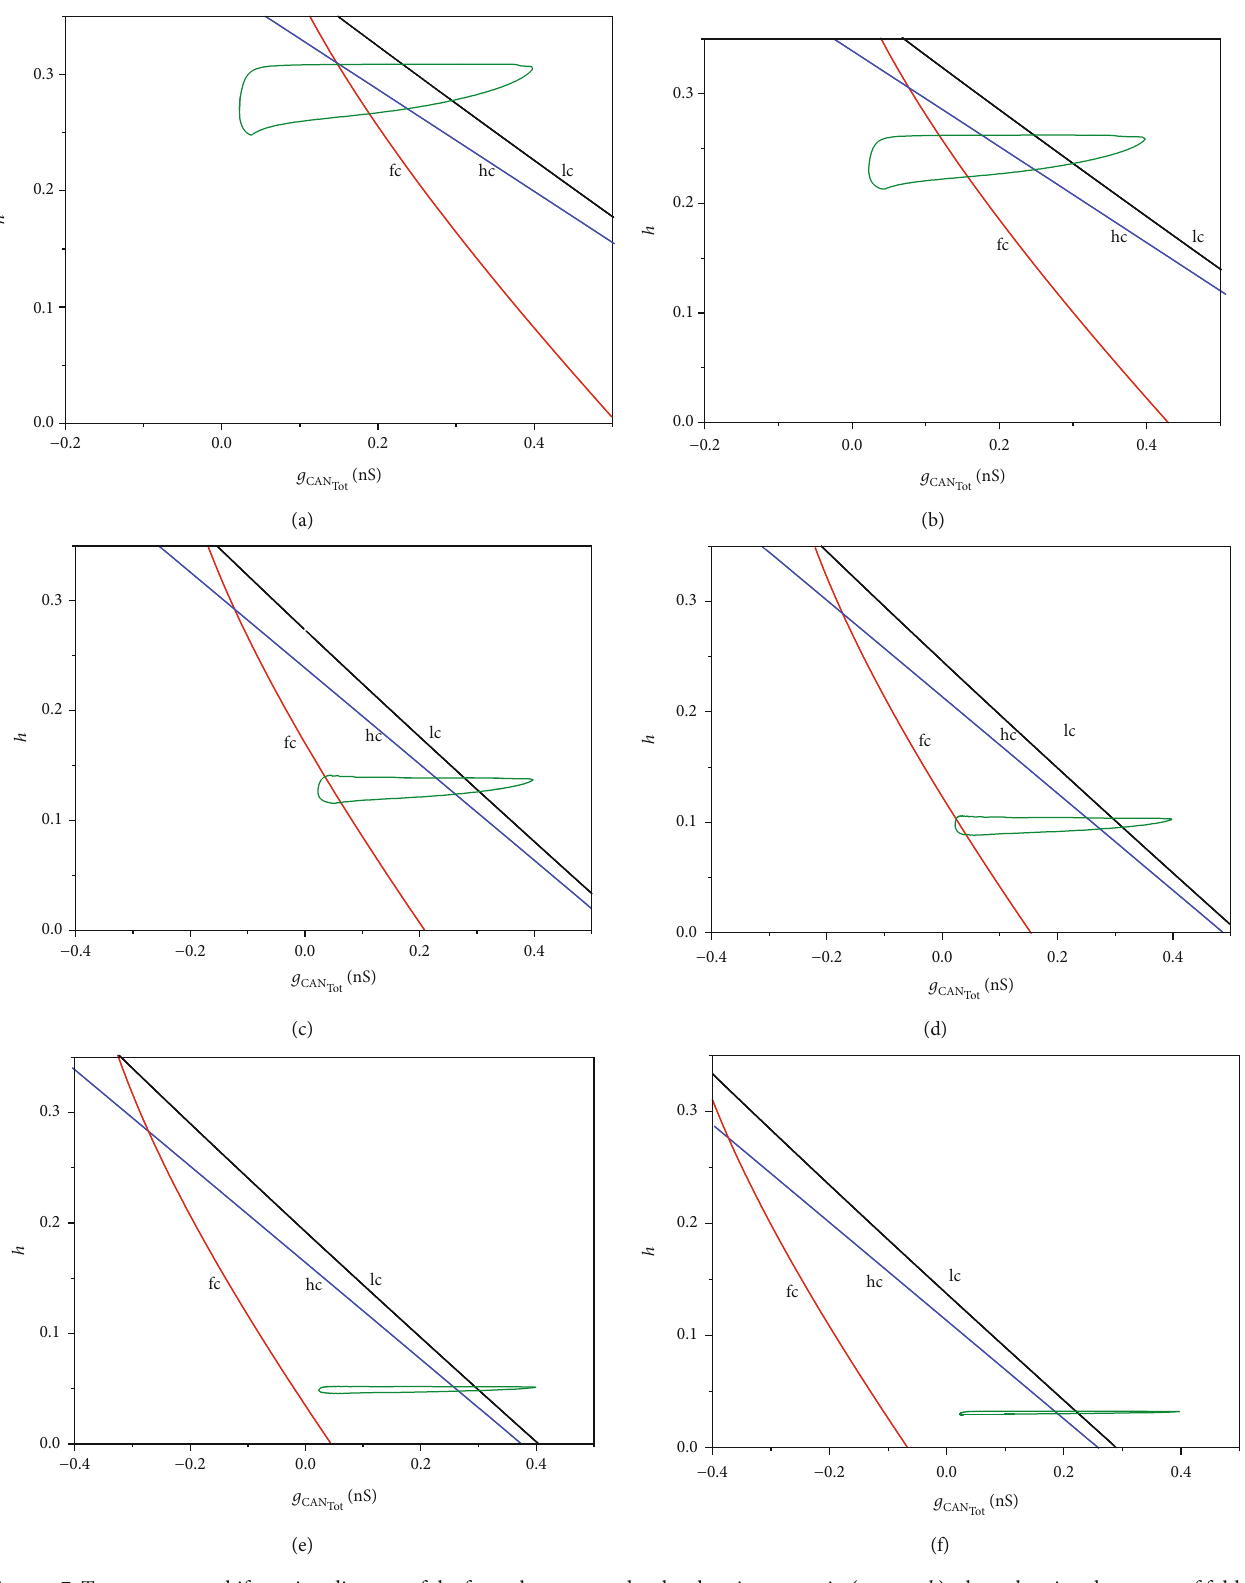
, h )-plane showing the curves of fold CAN Tot = − 2 μ A/cm 2 ; (b) I = 5 μ A/cm 2 ; (c) I = 25 μ A/cm 2 ; (d) I = 30 μ A/cm 2 ; (e) I = 40 μ A/cm 2 ; (f) extz extz extz extz extz